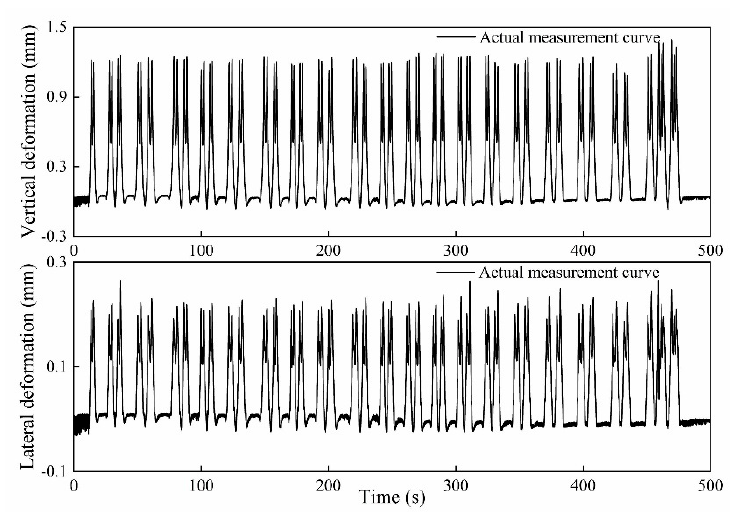
Figure 19. The vertical and lateral measuring waveforms on the site.